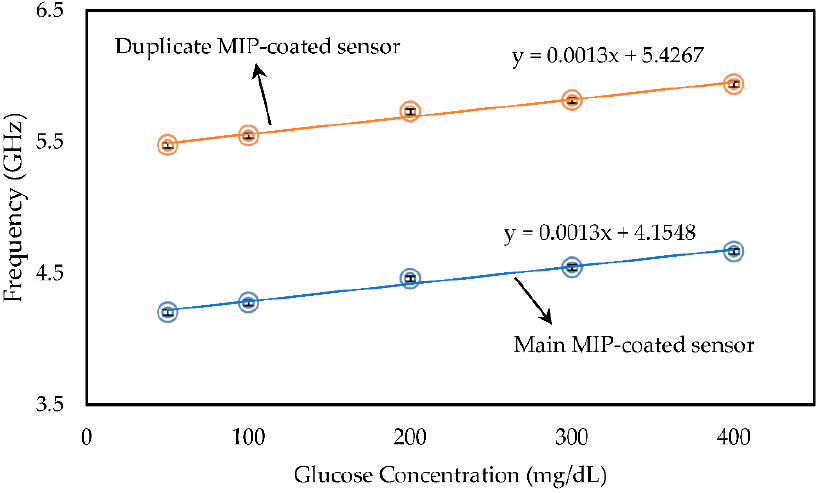
Figure 12. Calibration graph for the main and duplicate MIP-coated microwave-based biosensors exposed to glucose solutions.